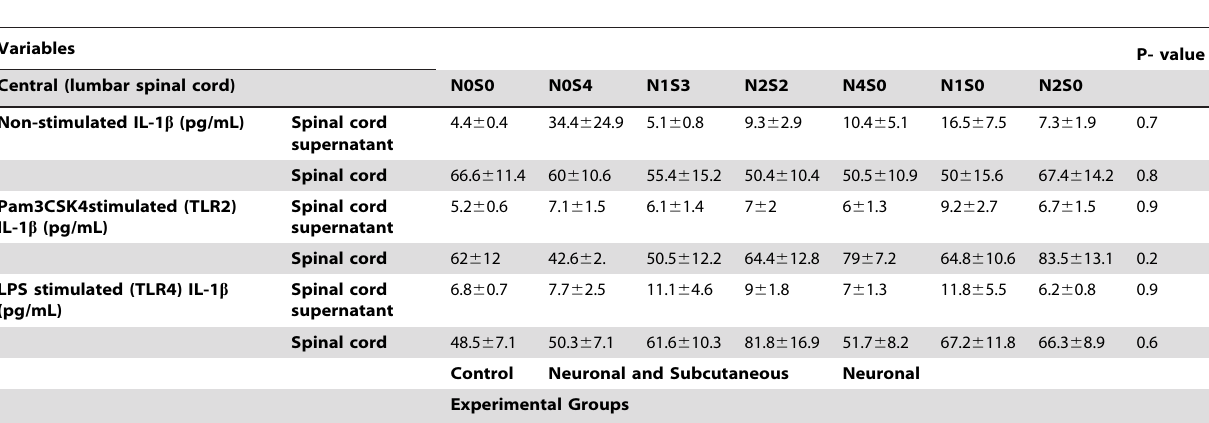
Table 2. Summary of variables collected from rats post CCI in the central